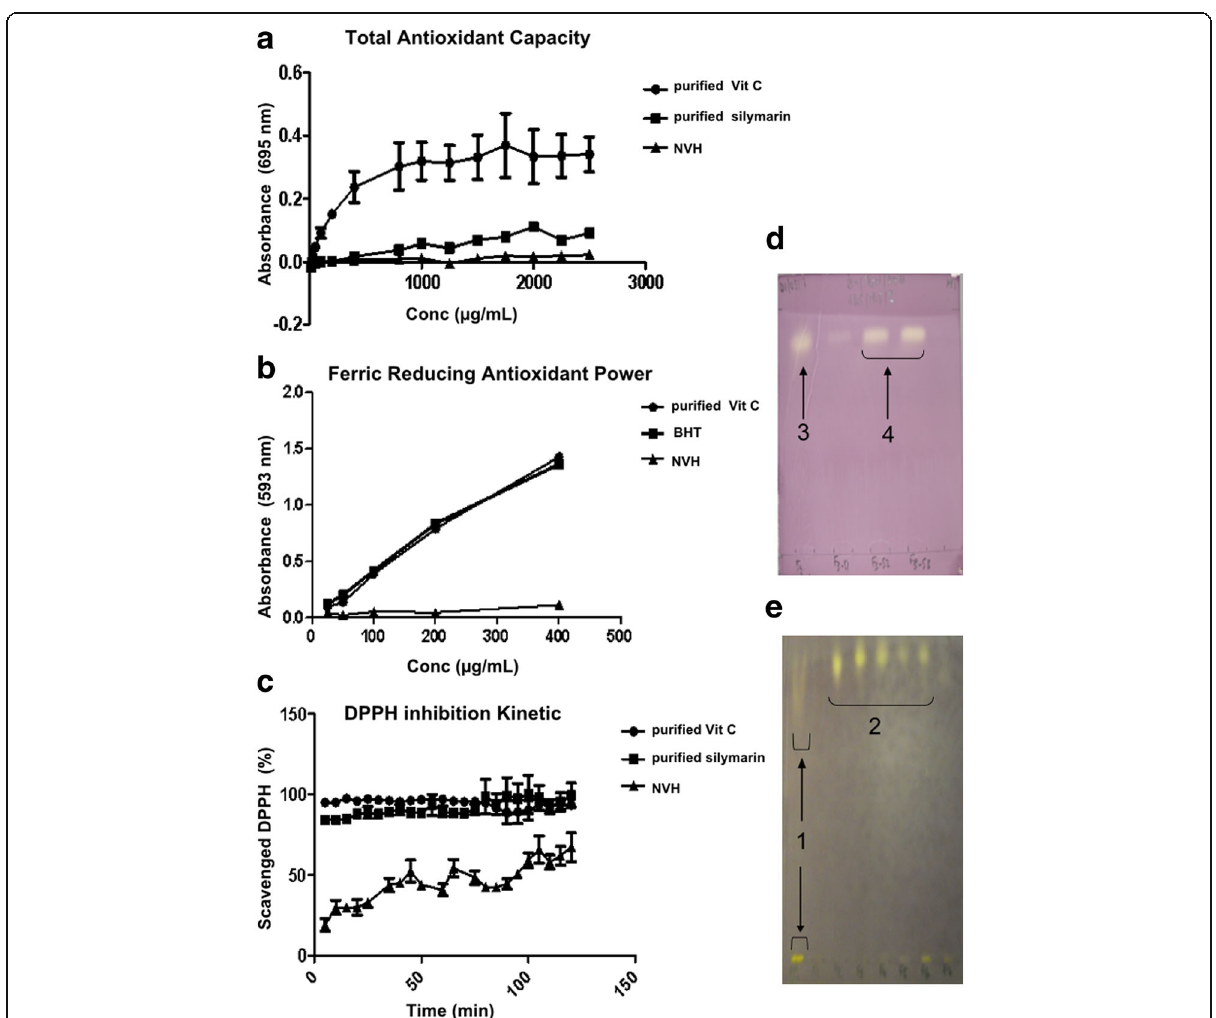
Fig. 12 In vitro extract antioxidant capacity and ferric reducing antioxidant power (FRAP). a : graph showing total antioxidant capacity of the extract (triangle) compared to vitamin C (circle) and silymarin (square). Results are expressed as optical density mean ± Standard Error of the Mean. b : graph showing the ferric reducing capacity of the extract (triangle) compared to vitamin C (circle) and BHT (square). Results are expressed as optical density mean. c : DPPH scavenging capacity of the extract. In 3 different experiments, the extract (triangle) DPPH inhibition kinetic was assay within 120 min. Vitamin C (circle) and silymarin (square) were used as references. ( d - e ): DPPH inhibition by TLC method. The DPPH scavenging capacities of the extract and its main fractions were visualized on silica plates after elution in water: methanol: acetic acid (12.5/ 12.5/1). Yellow points represent the scavenging capacity of the extract and its main fractions and compound. One and 2 respectively represent the contact points of the extract and its main fractions with DPPH while 3 and 4 respectively represent the contact points of F3 fraction and F3_52 – 53 compound with DPPH. DPPH: 1,1-diphenyl-2-picrylhydrazyl; NVH: Neoboutonia velutina aqueous extract; TLC: thin layer